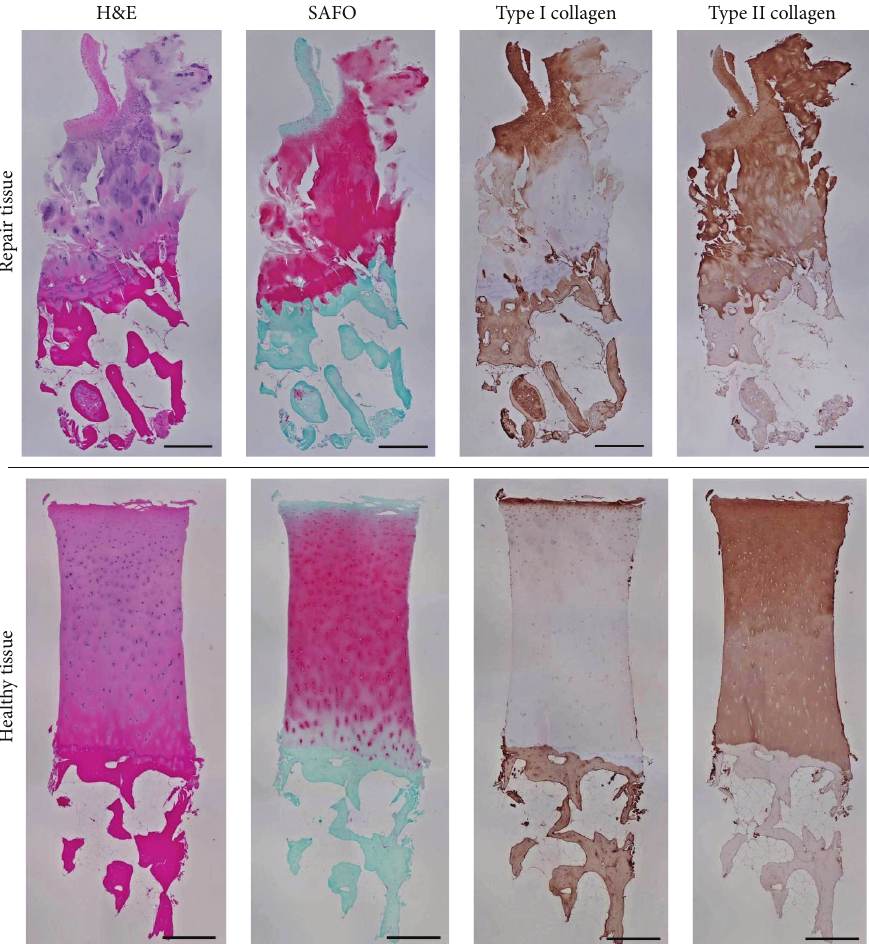
Figure 5: Histological stains. Histological stains of the biopsies of cartilage and underlying bone that were taken from the site of the chondral allograft implantation on the trochlea at nine months following the repair (repair tissue) and from the trochlea of a cadaver (healthy tissue, for comparison). Scale bars = 500 𝜇